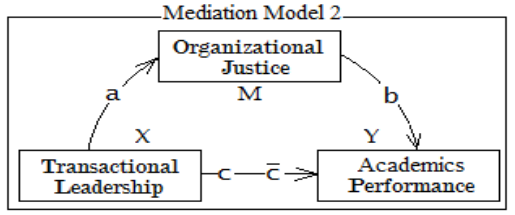
Figure 3. Mediation Model 2.